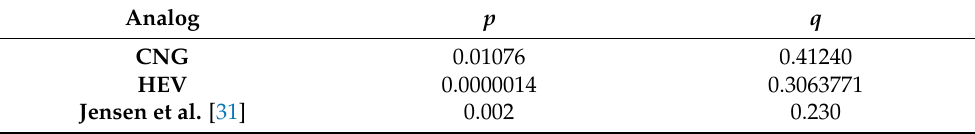
Figure 3. Estimation of EV diffusion in the city of Turin considering three possible options ’by analog’. Table 3. Estimated Bass’ coefficients by the different analog approaches.